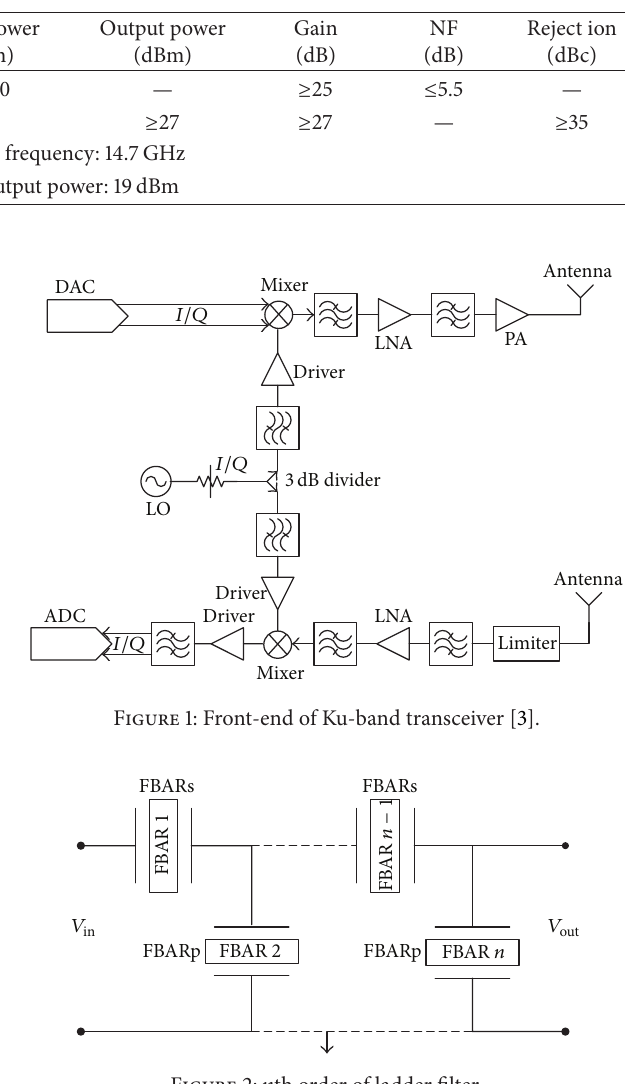
Figure 2: 𝑛 th order of ladder